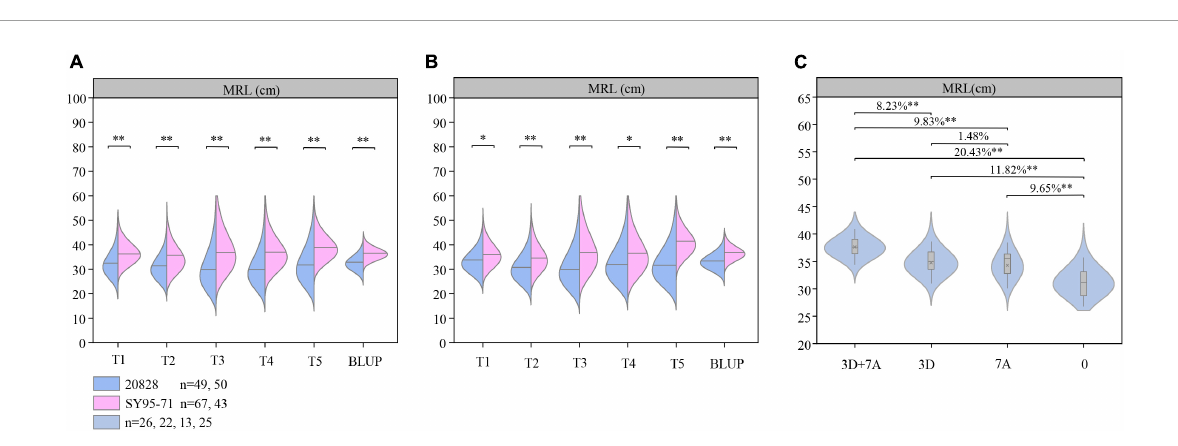
higher than others indicating that these two loci can